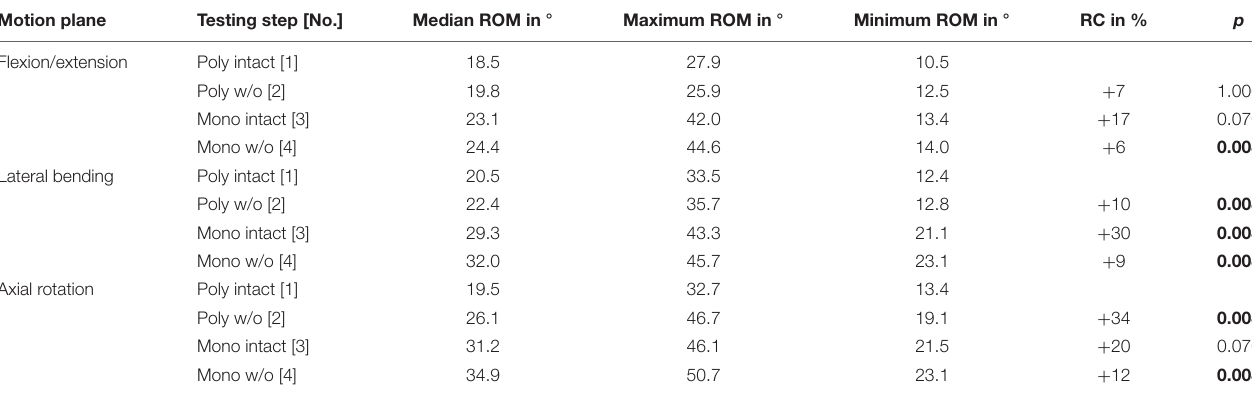
TABLE 3 | Results for T1-T12 range of motion as sum of the six tested segmental levels (T1-T2 + T3-T4 + ... ) at pure moments of ± 5 Nm ( n = 8) depending on primary motion plane and testing step. Motion plane Testing step [No.] Median ROM in ◦ Maximum ROM in